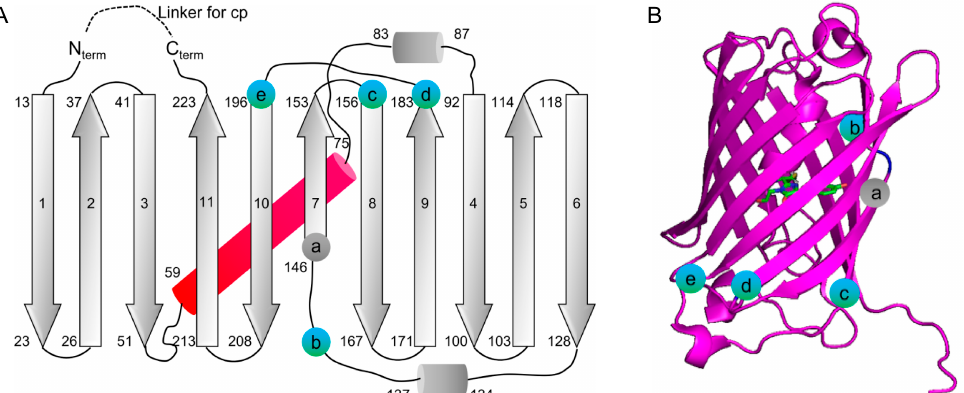
Figure 1. Location of mMaroon1 circular permutation sites explored in this study. ( A ) Unsuccessful and successful circular permutation sites are labeled as grey and blue spheres, respectively, on the secondary structure elements of mMaroon1. Residue numbers for the start and end of secondary structure elements are based on an mMaroon1 structure predicted by SWISS-MODEL using mCardinal (PDB: 4OQW) as the template. Cylinders represent α -helices and arrows represent β -strands. β -strands are labeled with consecutive numbers, indicating their positions in the secondary structure. Grey or blue circle labels the first residue of each circular permutation construct: (a) cpmMaroon145-148, (b) cpmMaroon141-152, (c) cpmMaroon158-152, (d) cpmMaroon185-186, (e) cpmMaroon196-186. ( B ) Cartoon representation of the structure of mMaroon1 predicted by SWISS-MODEL using mCardinal (PDB: 4OQW) with positions of circular permutation denoted in ( A ). The chromophore is presented in sticks mode.